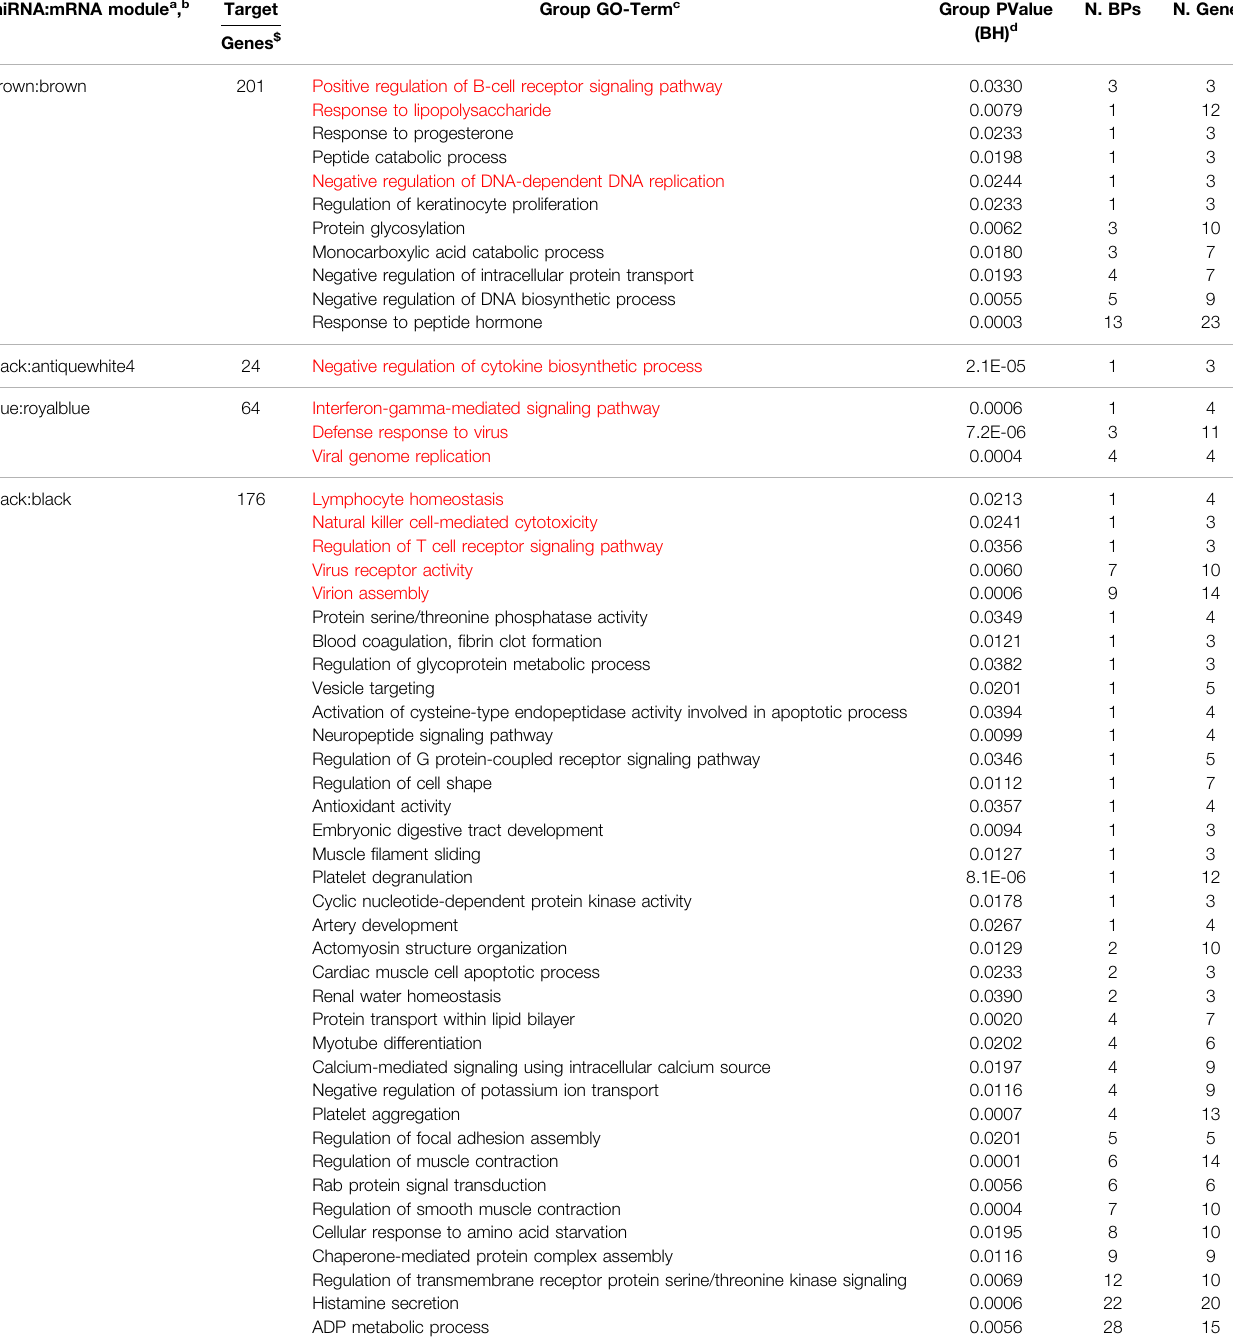
TABLE 2 | Summary of enriched Gene Ontology (GO) biological processes (BP) for four miRNA:mRNA co-expression interaction networks in the topsoil group. miRNA targets contained in the correlated mRNA module were used for the